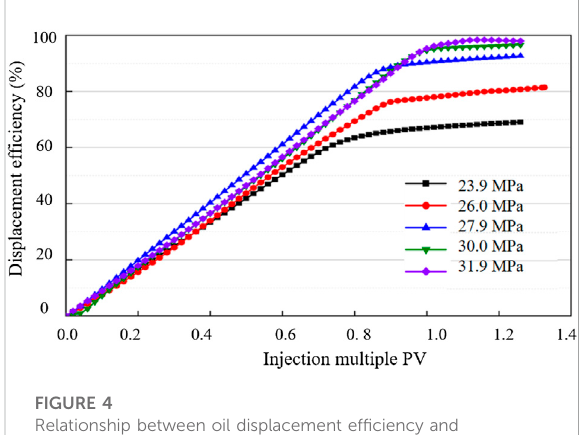
FIGURE 4 Relationship between oil displacement ef fi ciency and injection multiple under different pressures.